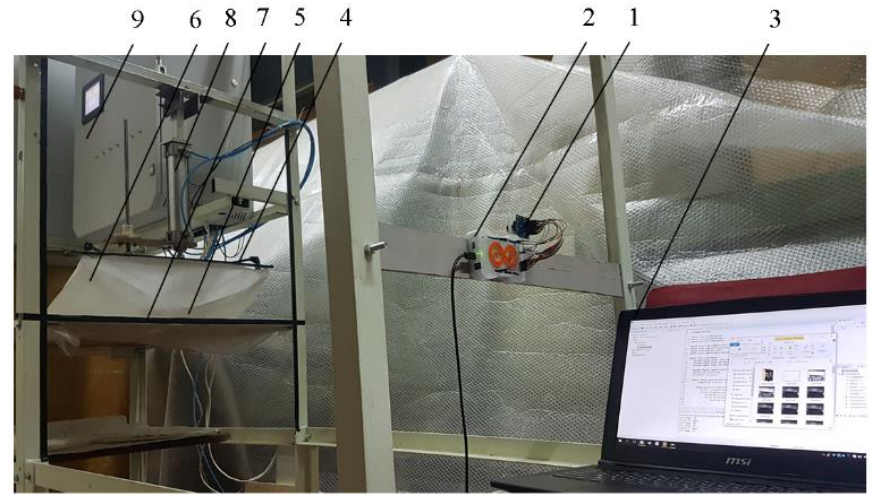
Figure 14. General view of the laboratory unit: 1, Raspberry Pi camera; 2, Raspberry Pi minicomputer; 3, laptop computer; 4, 5, vacuum gripping devices (VGDs); 6, flexible container; 7, table; 8, pneumatic cylinder; 9, control board.